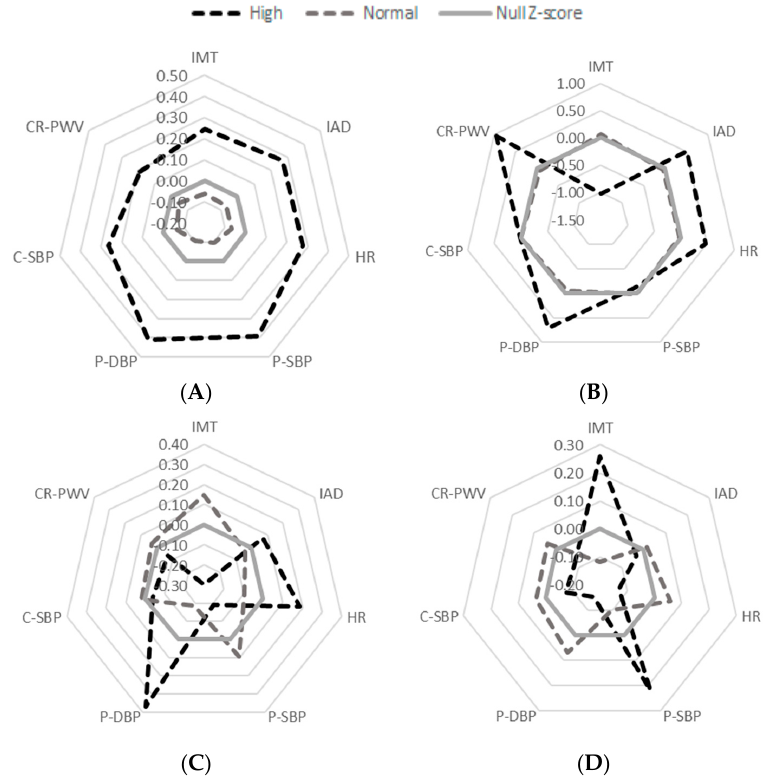
Figure 3. Reader graphs of normal/high TG concentrations against the vascular markers of atherosclerosis without the usage of Statin in ( A ) the total sample, ( B ) control group (CG), ( C ) at-risk of developing atherosclerosis group (ARG), and ( D ) diagnosed with atherosclerosis group (DAG). HR—heart rate; C-SBP—central systolic blood pressure; P-SBP—peripheral systolic blood pressure; P-DBP—peripheral diastolic blood pressure; CR-PWV—carotid-radial pulse wave velocity; IMT—intima-media thickness; IAD—inter-adventitial